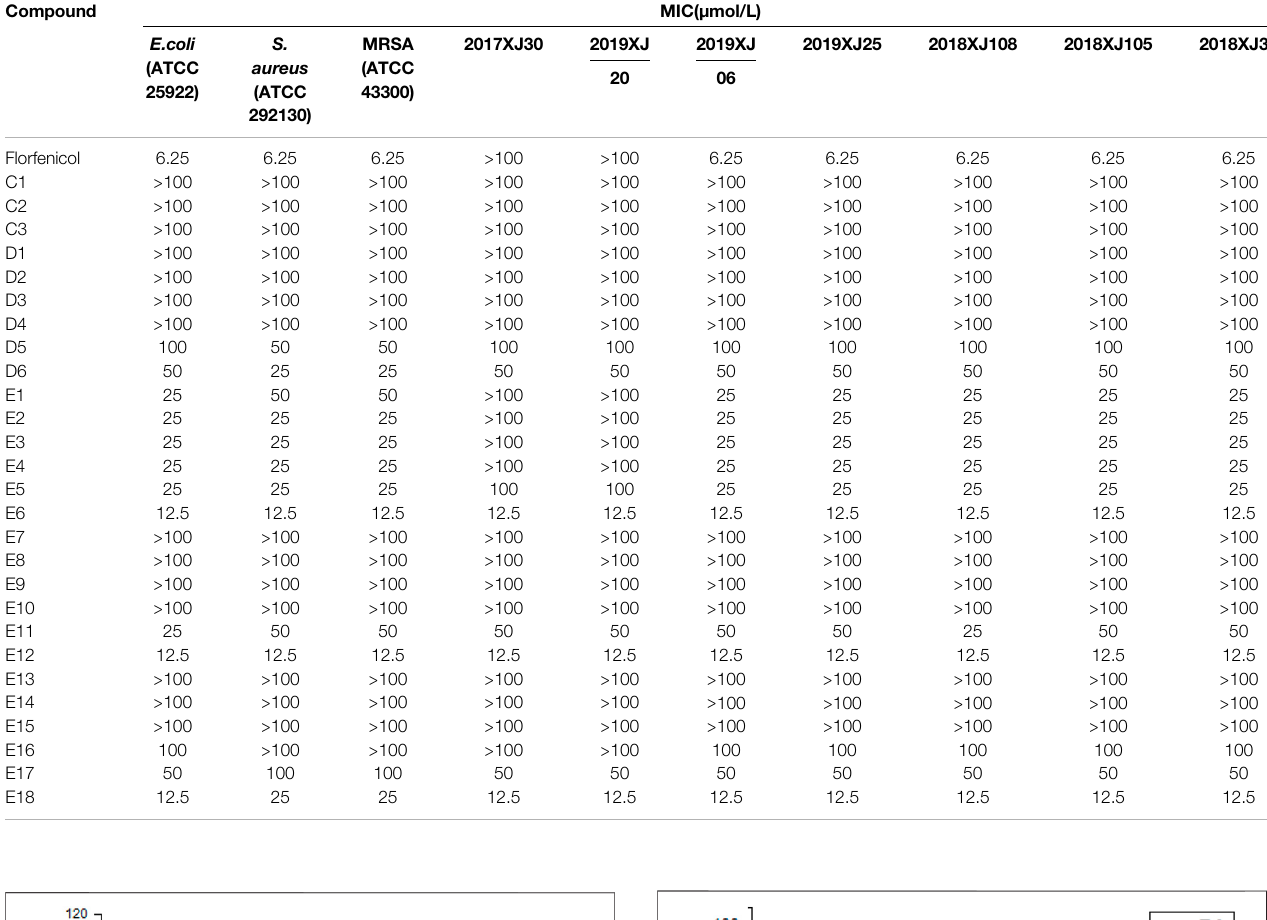
TABLE 2 | Minimal inhibitory concentrations (MICs) of the compounds.